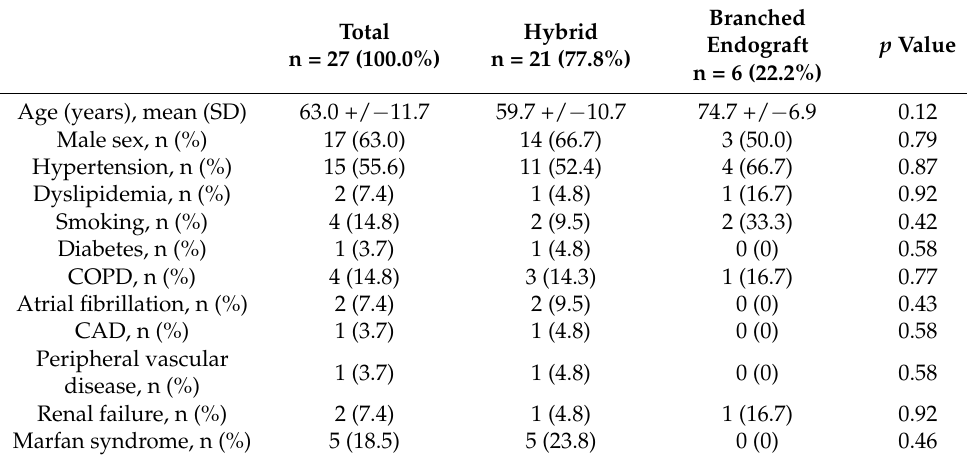
Table 2. Baseline characteristics of patients with reintervention for distal aneurysmal evolution including aortic arch